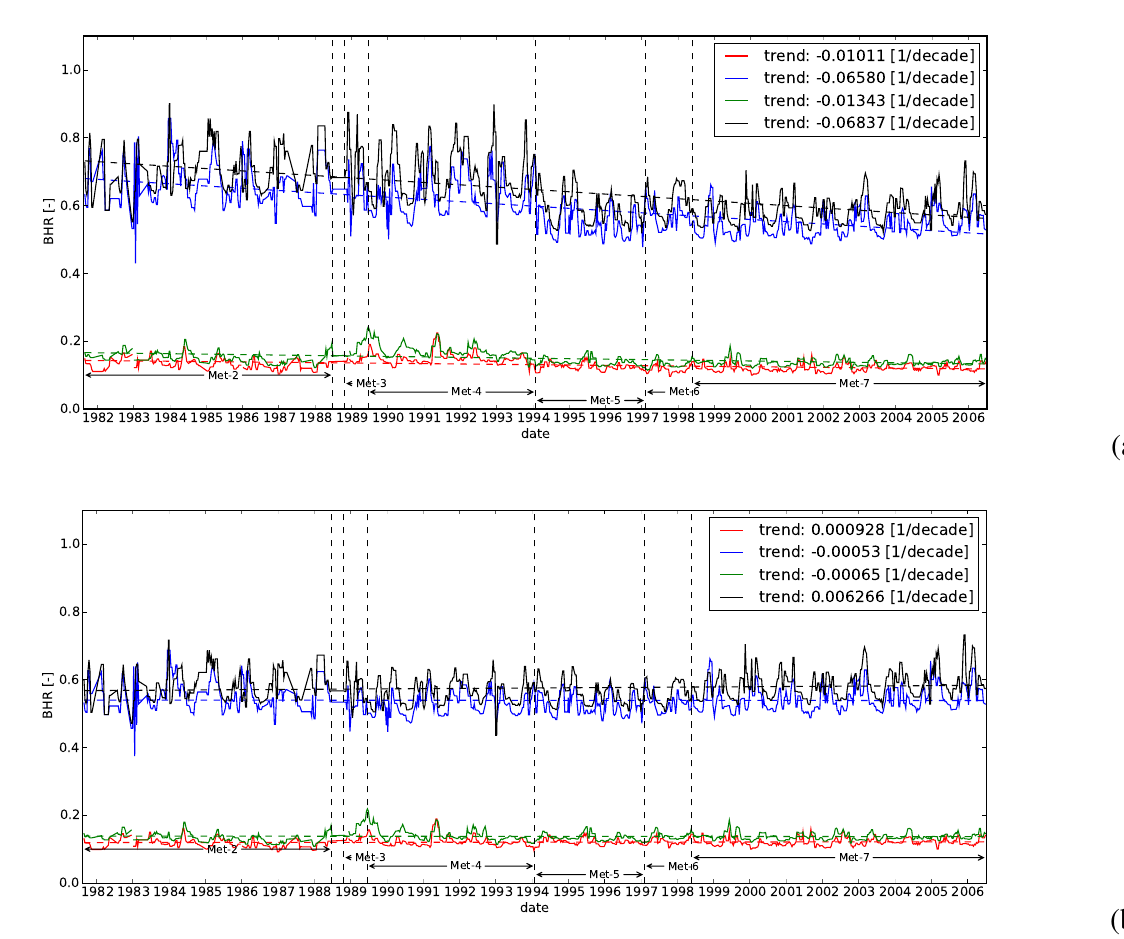
Figure 2. Surface albedo ( BHR ) time series for dark and bright desert targets for iso,bb different spectral conversion approaches: (a) broadband albedo with standard conversion coefficients, (b) broadband with new conversion coefficients; different lines correspond to different